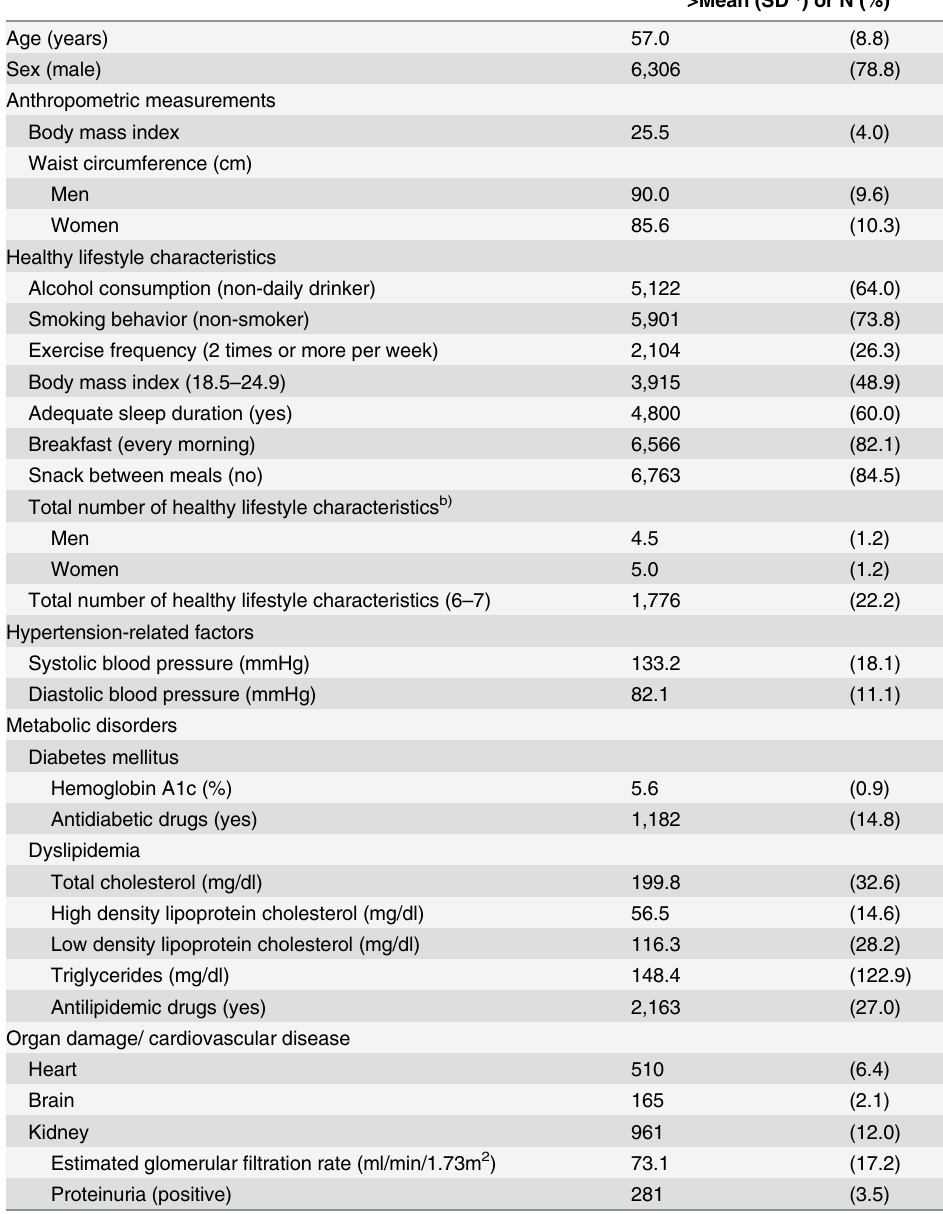
Table 1. Participant characteristics at baseline survey (N =